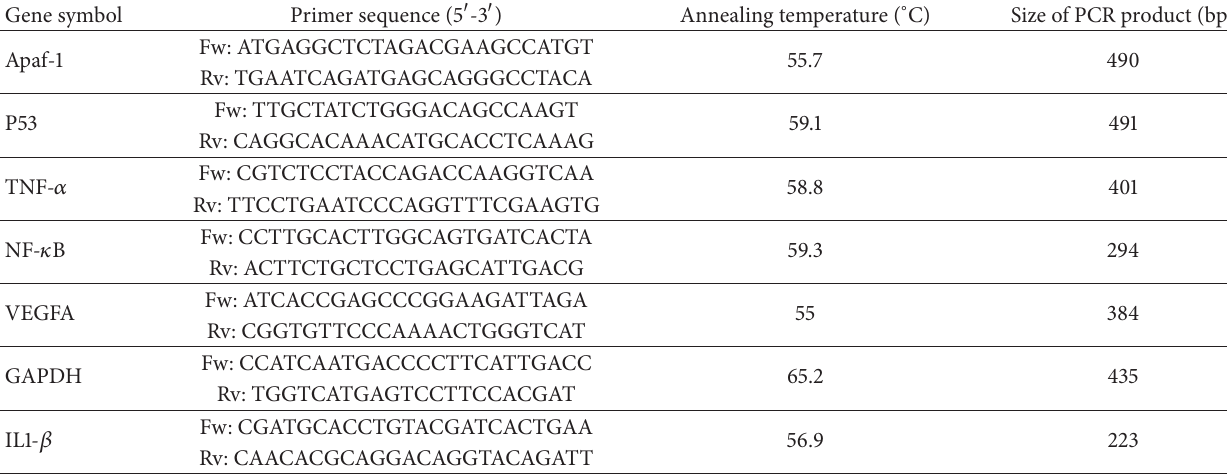
Table 1: Primers and conditions employed for evaluation of gene